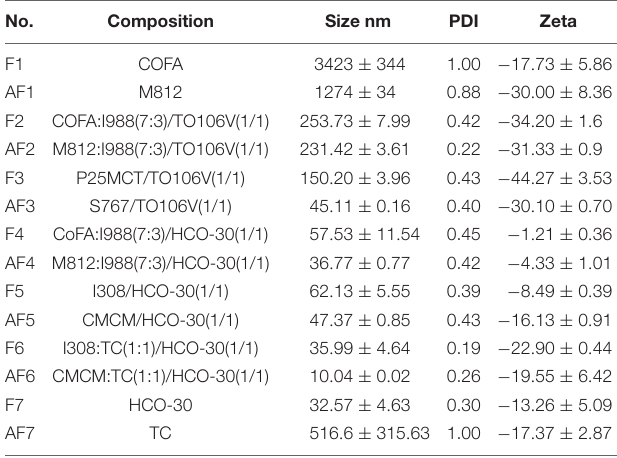
TABLE 2 | The particle size, PDI, and zeta potential (surface charge) of TAL loaded various LFCS formulations.